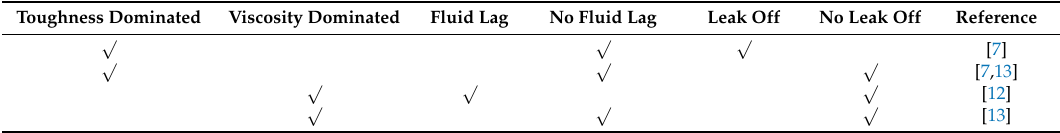
Table 2. Applications of nondimensionalization to deriving analytical or numerical solutions to transverse radial